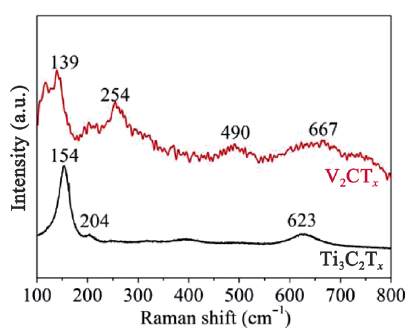
Fig. 4 Raman spectra of Ti 3 C 2 T x and V 2 CT x